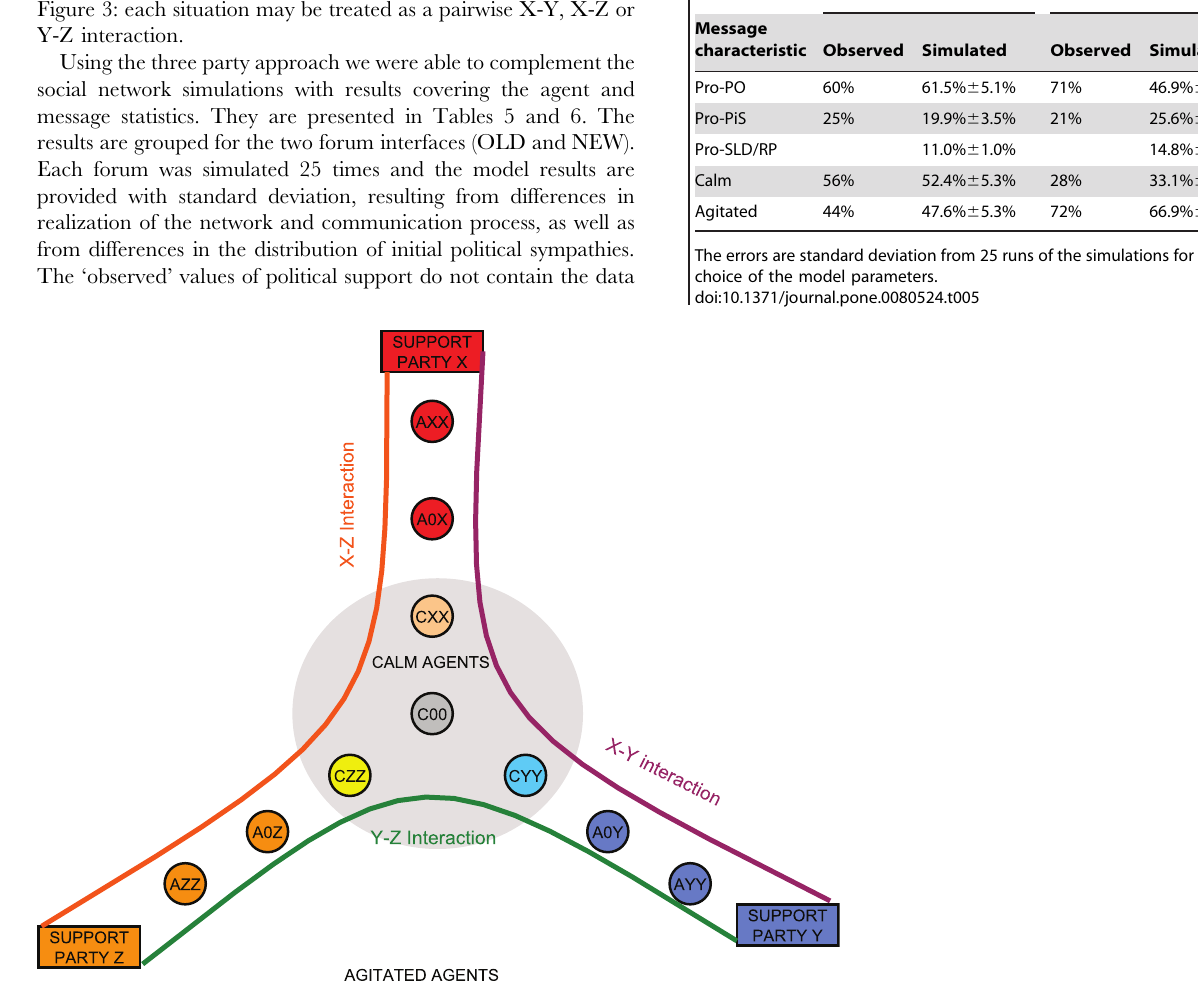
Figure 3: each situation may be treated as a pairwise X-Y, X-Z or Y-Z interaction.